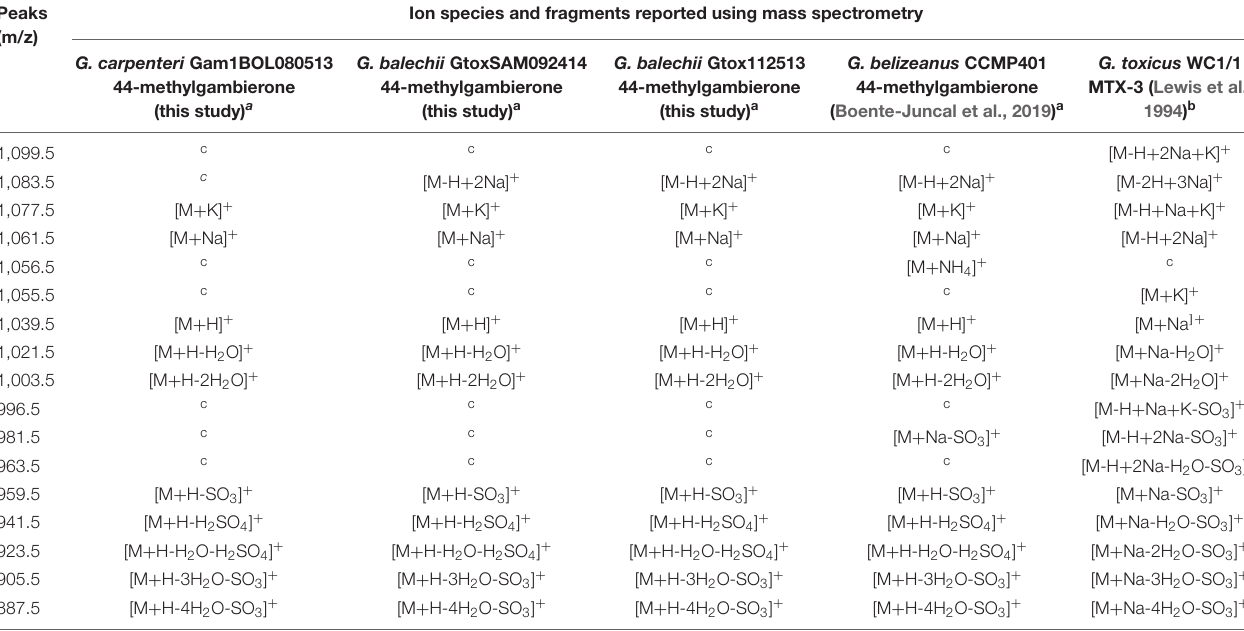
Ion species and fragments reported using mass